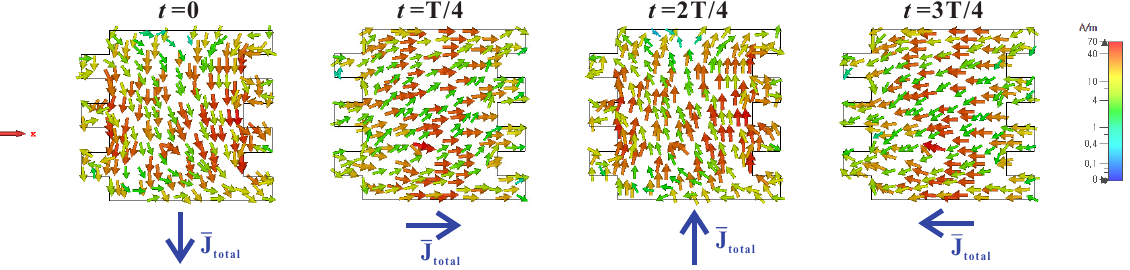
Figure 4. Simulated surface current distributions on the corrugated patch at the operating frequency.